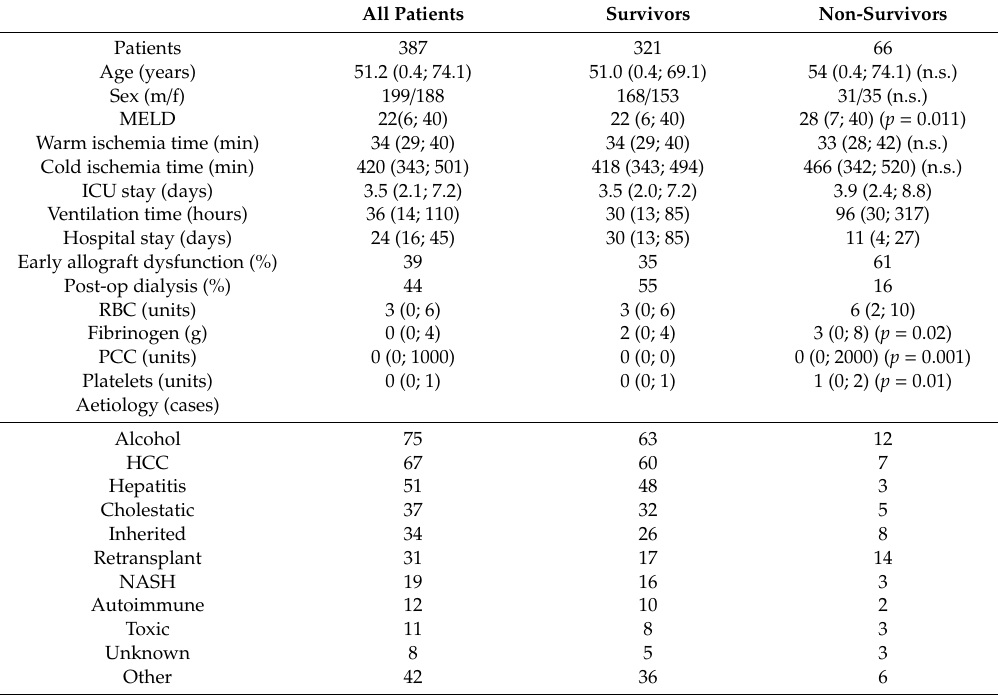
Table 1. Demographic and baseline clinical data of liver transplantation patients (all patients, survivors and non-survivors). Age, model of end-stage liver disease (MELD), warm and cold ischemia time, ICU-stay, ventilation time, and hospital stay as well as blood products and retransfused cell saver blood are given as median and quartiles. For statistical evaluation, the Wilcoxon test and the Chi-square test were used, as appropriate. n.s.-not